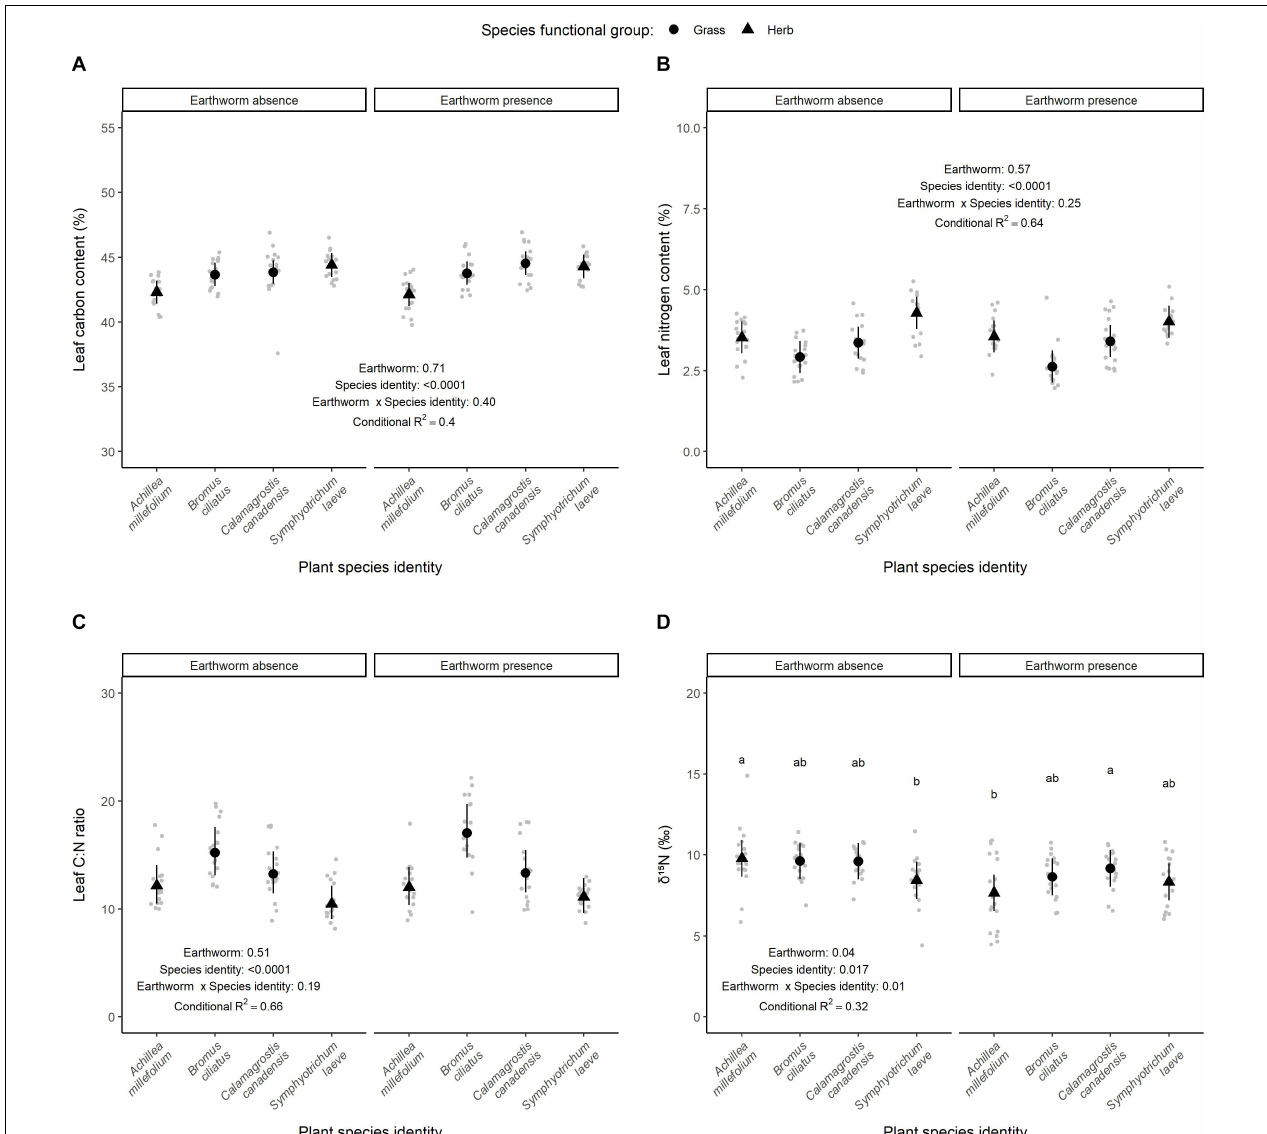
FIGURE 5 | Effect of earthworm presence on leaf carbon (A) and nitrogen (B) content as well as their C/N ratio (C) and δ 15 N signature (D) . Estimated marginal means and confidence intervals are shown in black (after being back-transformed), while data points were included in the background in gray. The conditional R 2 as well as the p -values for each factor are based on linear mixed effect models. When the interaction between earthworm treatment and species identity were significant, post hoc test results are also presented: different letters show significant differences among species within each earthworm treatment. Number of observations per species and treatment: 18, except for S. leave in the control treatment, where there are 17 observations.